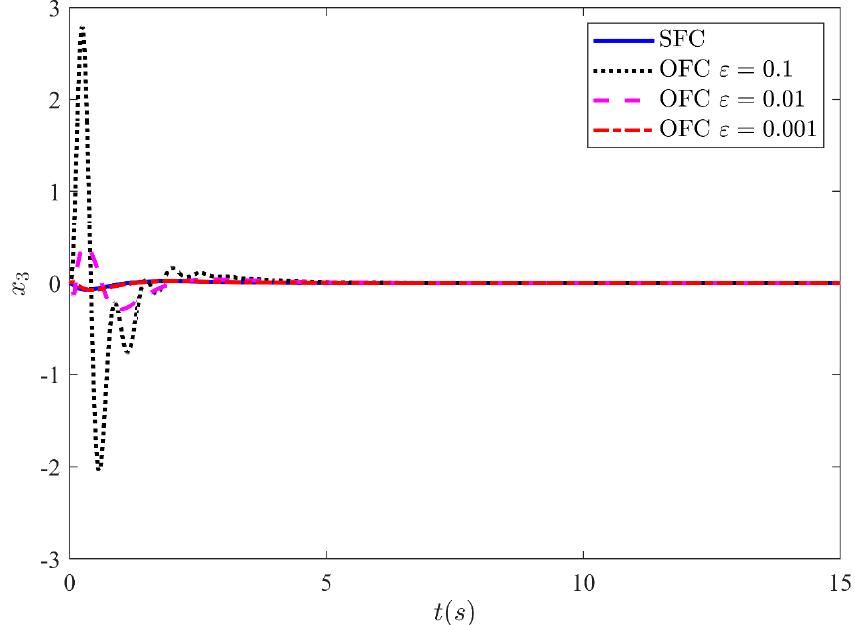
Figure 11. HGO based on SMC state x 3 for three different values of ε .